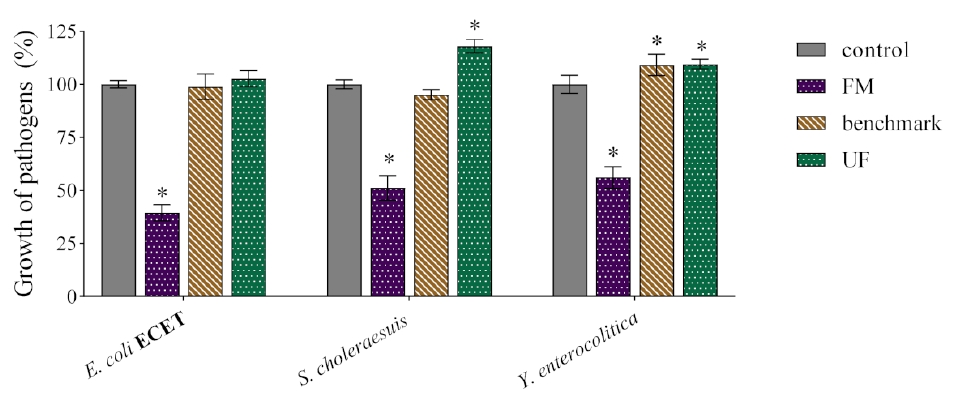
Figure 3. Effects of FM, benchmark and UF on the growth of E. coli ECET, S. choleraesuis and Y. enterocolitica (mean ± SD, n = 3). * p <